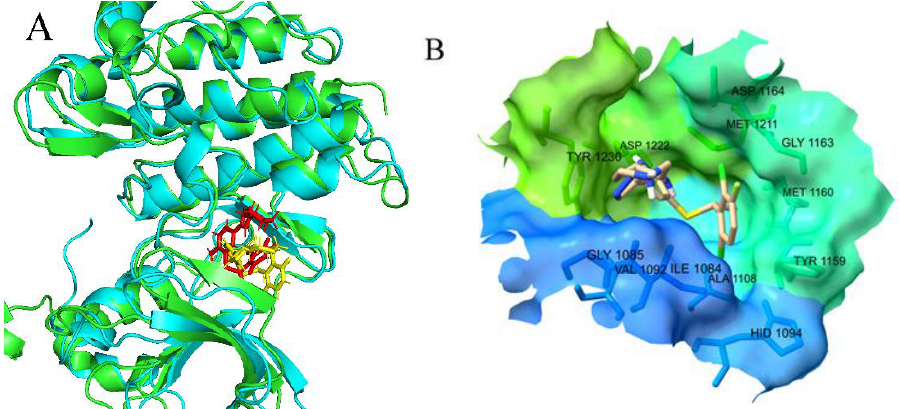
Figure 10. The ligand location comparison of the initial structure and after MD stabilized conformation. ( A ) Overlay of the first frame structure and the last frame structure of the trajectory, this green is the protein structure of the first frame and this red is the small molecule structure of the first frame, this blue is the protein structure of the last frame and this yellow is the small molecule structure of the last frame; ( B ) the amino acid residues around the binding site.